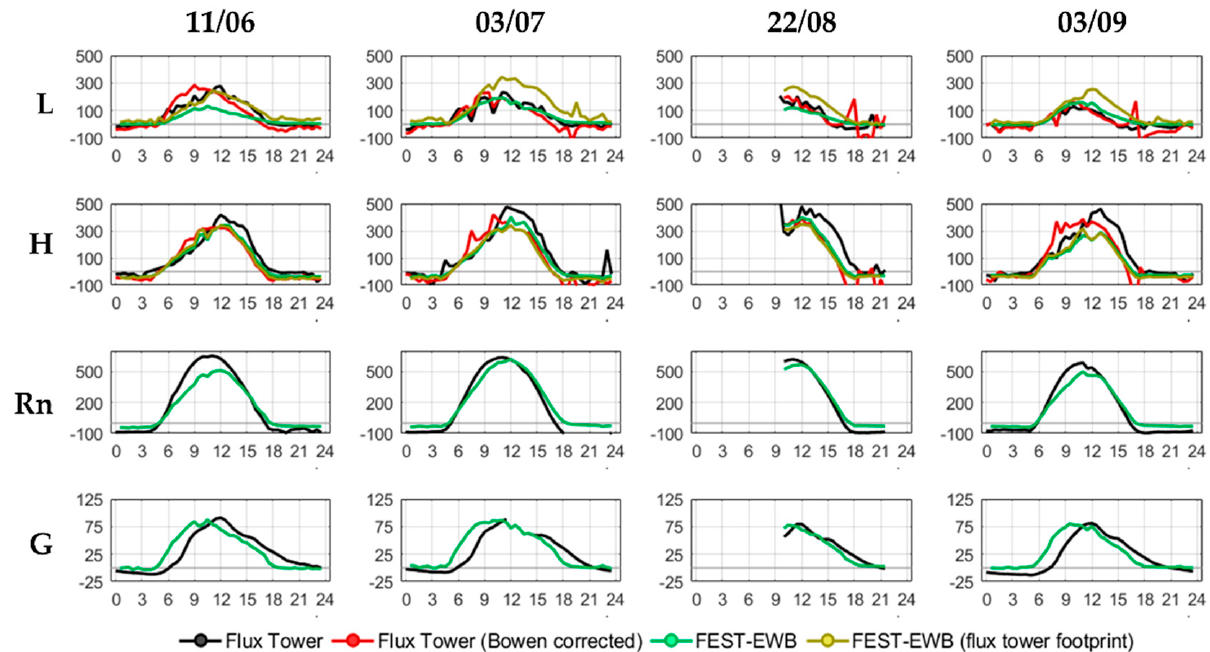
Figure 5. Daily energy fluxes, expressed in W m − 2 against time (in hours). Fluxes are grouped by row (“L” = Latent Heat, “H” = Sensible Heat, “Rn” = Net Radiation, “G” = Soil Heat Flux), whereas validation dates are organized by column.